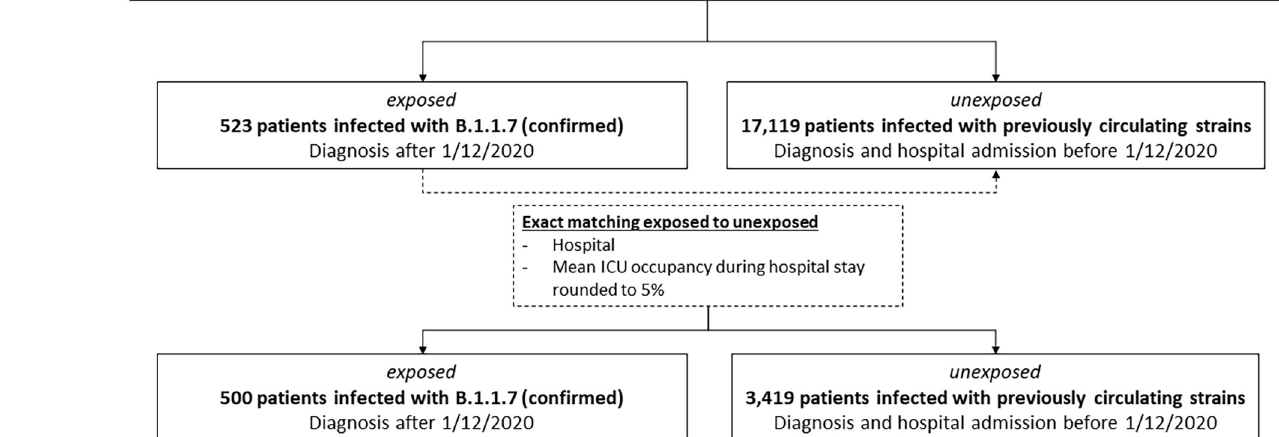
Fig 1. Flow chart for the selection of patients within a multi-center matched cohort study to assess the impact of SARS-CoV-2 variants on COVID-19 disease severity among hospitalized patients in Belgium.